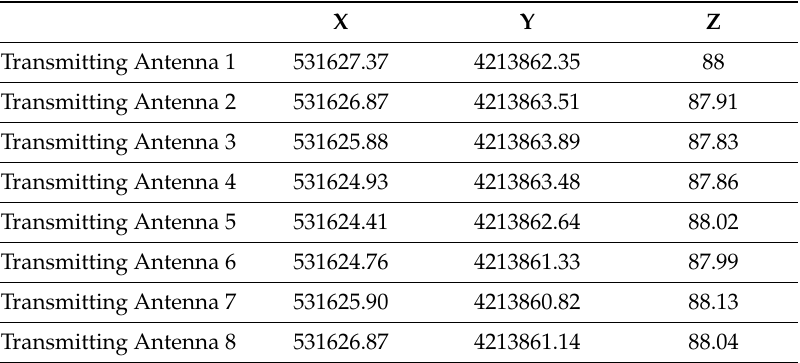
Figure 3. Experimental environments and setup. Table 1. Coordinates of eight transmitting antennas.